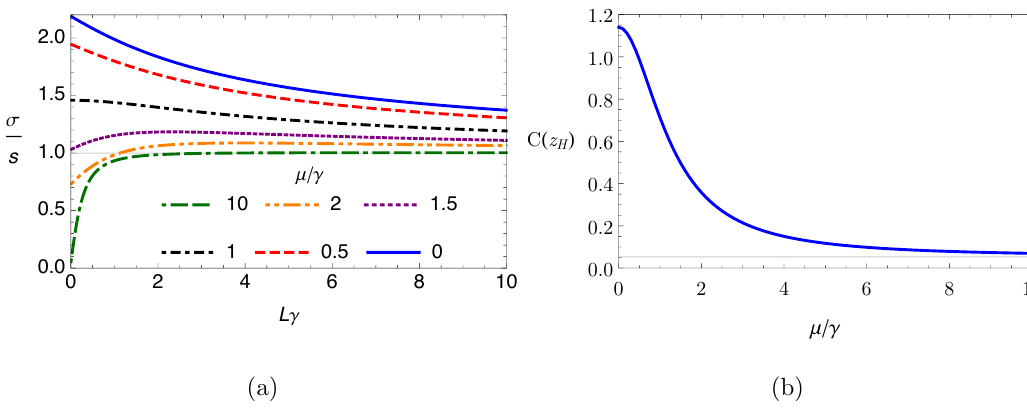
Figure 16. (a) The ED, (cid:27) , in units of entropy density s , versus L(cid:13) for the strip in the solution of eq. (7.4) with T=(cid:22) = 0, showing the intercept increase and the slope change sign at small L(cid:13) as (cid:22)=(cid:13) decreases from 10 to 0. (b) The dimensionless coe(cid:14)cient C ( z H ) from eq. (2.23) versus (cid:22)=(cid:13) . As (cid:22)=(cid:13) ! 1 , C ( z H ) approaches the value for extremal AdS-RN with d = 3 (the horizontal line). Clearly C ( z H ) > 0 for all (cid:22)=(cid:13) , indicating area theorem violation.